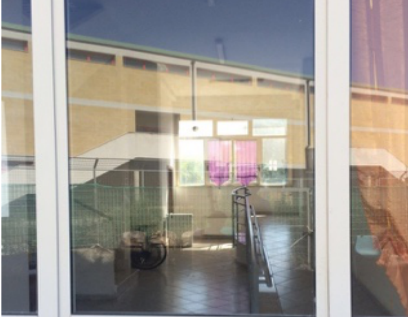
Figure 11. Window used for the experiment